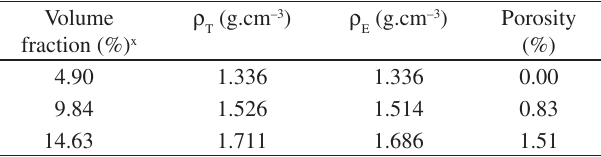
Table 1. Theoretical ( ρ porosity of composites with different CCTO volume fraction (determined through x TGA).